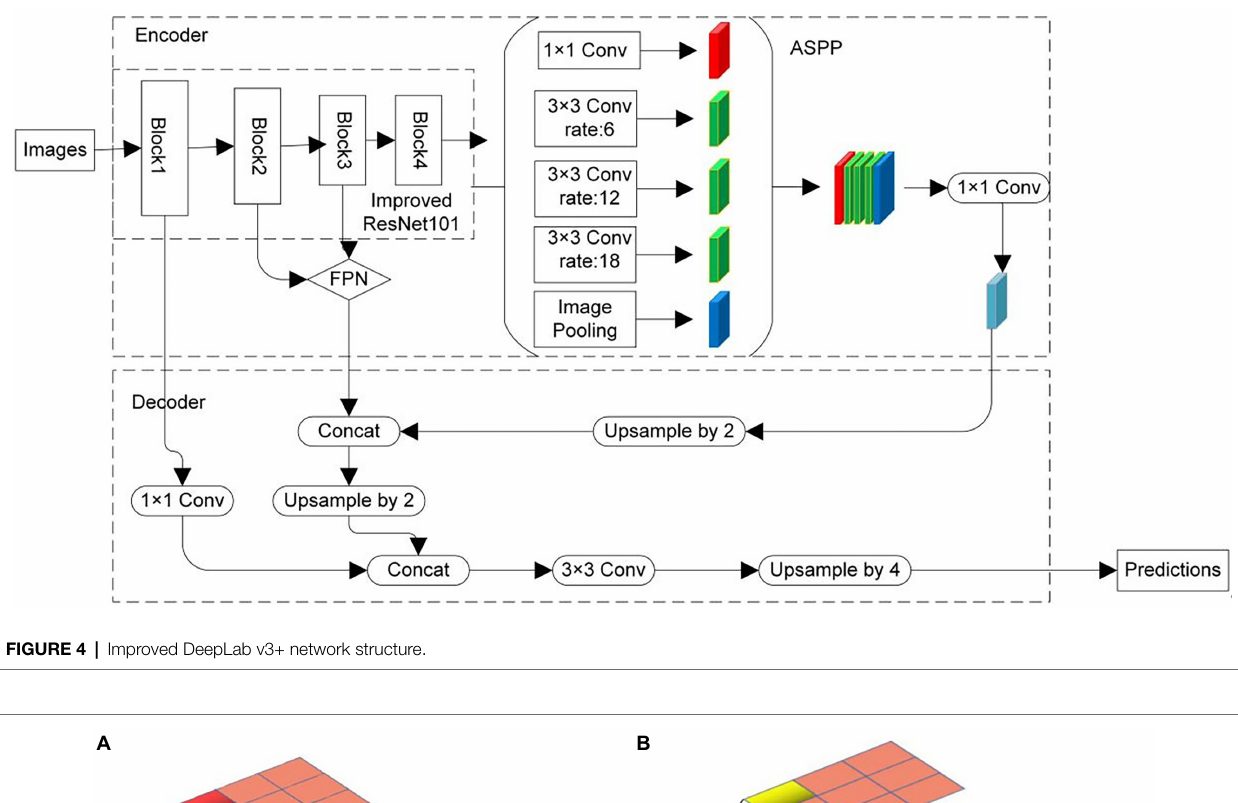
FIGURE 4 | Improved DeepLab v3+ network structure.